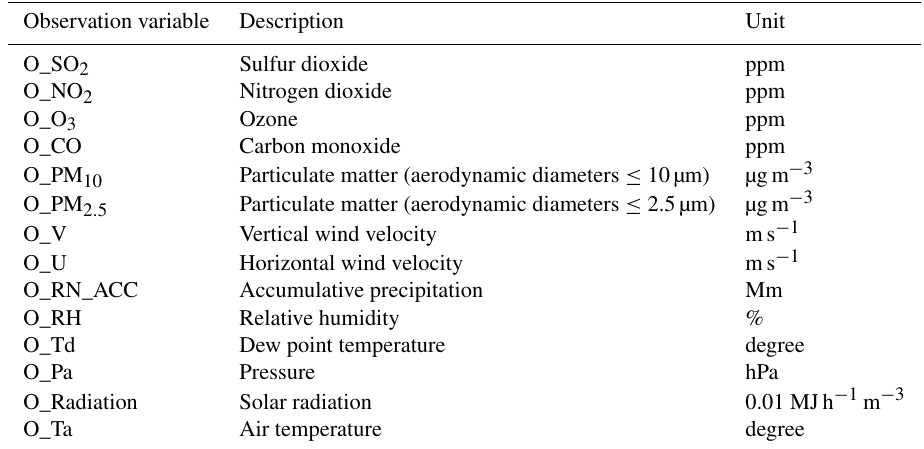
Table 1. Training variables in the PM 2 . 5 prediction system using a DNN based on surface-weather observations. Air quality variables were obtained from 41 air quality measurement equipment in Seoul. Surface weather variables were obtained from ASOS in Seoul. Observation data were collected every hour.